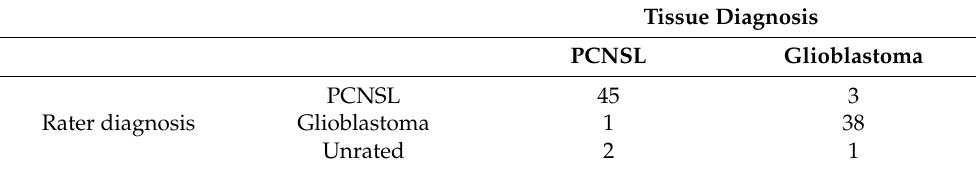
Table 4. Neuroradiologist whole brain visual assessment using T 1 CE images, T 2 images, and ADC